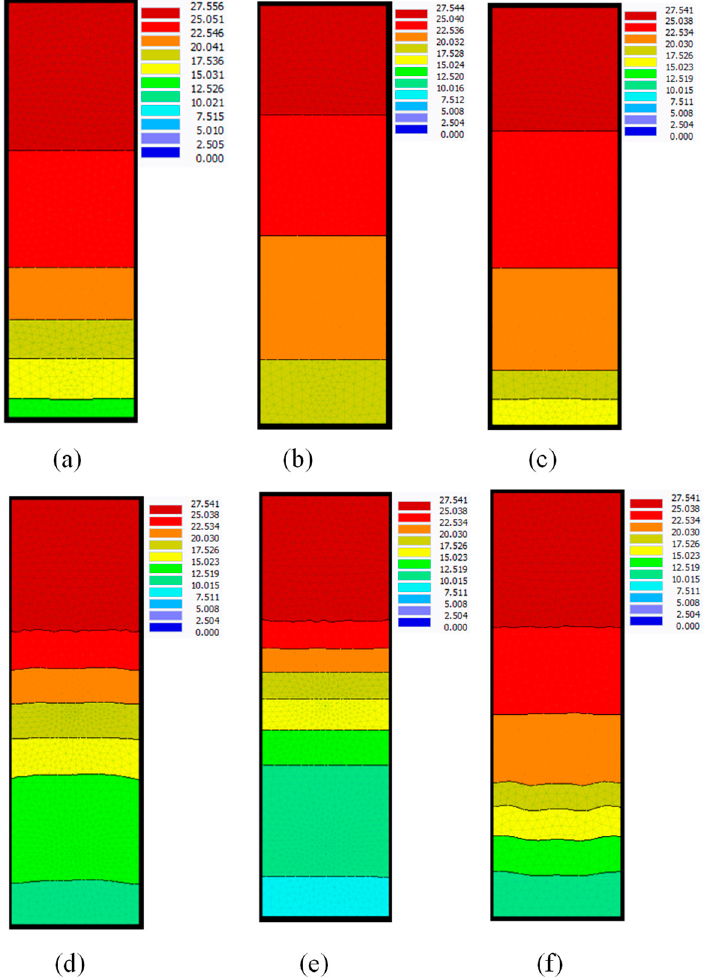
Figure 6. Calibrated Nitrate Concentrations HYDRUS Graphical Outputs: ( a ) Sand, ( b ) Cedar Canyon, ( c ) Alluvial, ( d ) Dense Woodchips, ( e ) Loose Woodchips, and ( f ) Biochar.